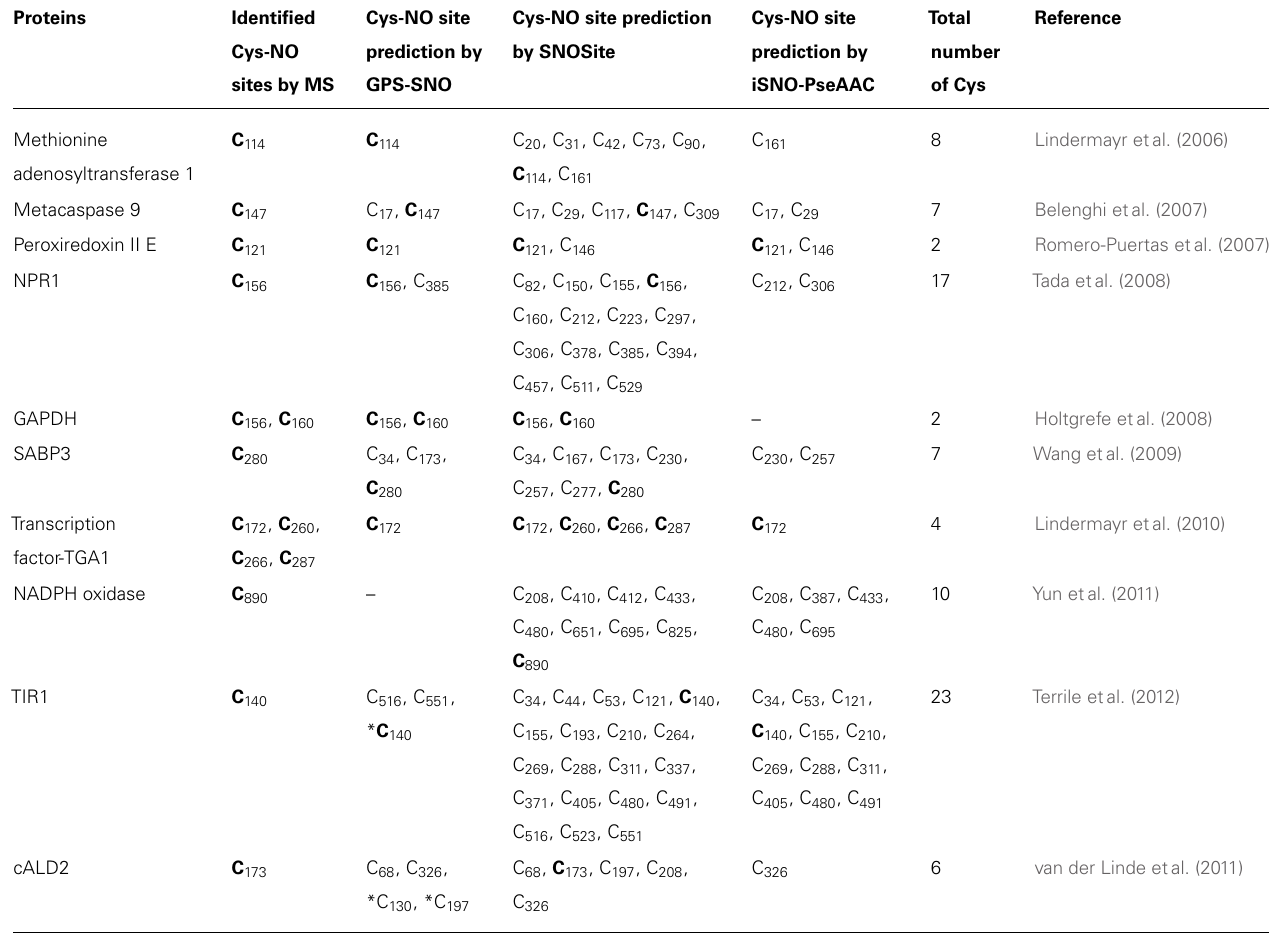
Table 2 | Computational prediction of S -nitrosylation sites from 10 experimentally identified S -nitrosylated proteins from Arabidopsis thaliana using GPS-SNO, SNOSite, and iSNO-PseAAC programs.